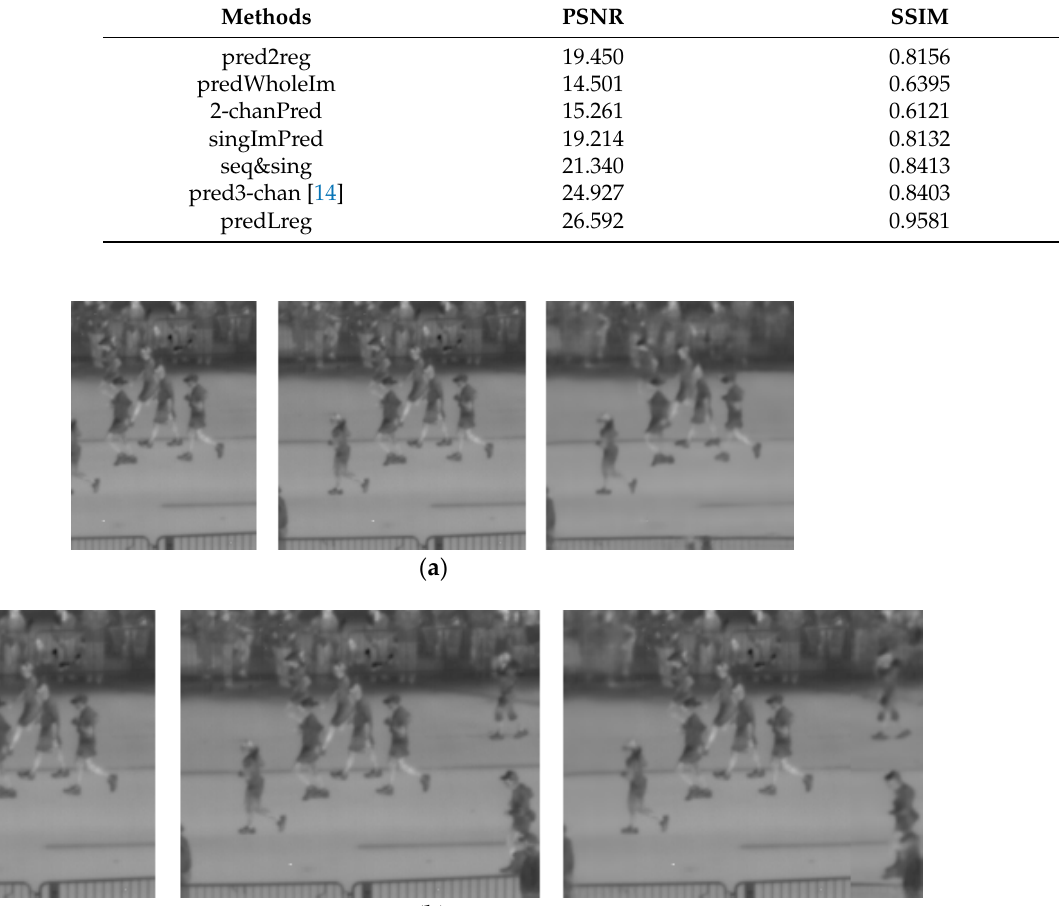
( b ) ( c ) Figure 9. Examples of result images obtained by predLRreg (proposed method): in ( a – c ), from left to right, original images, GT images, and predicted (output) images. In the next experiment, the results of detecting humans in the original input image and GT image were compared with the result of detecting humans in the image predicted by the proposed method for examining the efficiency of the proposed method. For a fair experiment, an identical Mask R-CNN [42] was used for the two methods during human seg-mentation. Figure 10 shows the result of human segmentation using Mask R-CNN as mask images. As shown in Figure 10, the result of human segmentation in the GT image and the result of human segmentation in the image predicted by the proposed method are